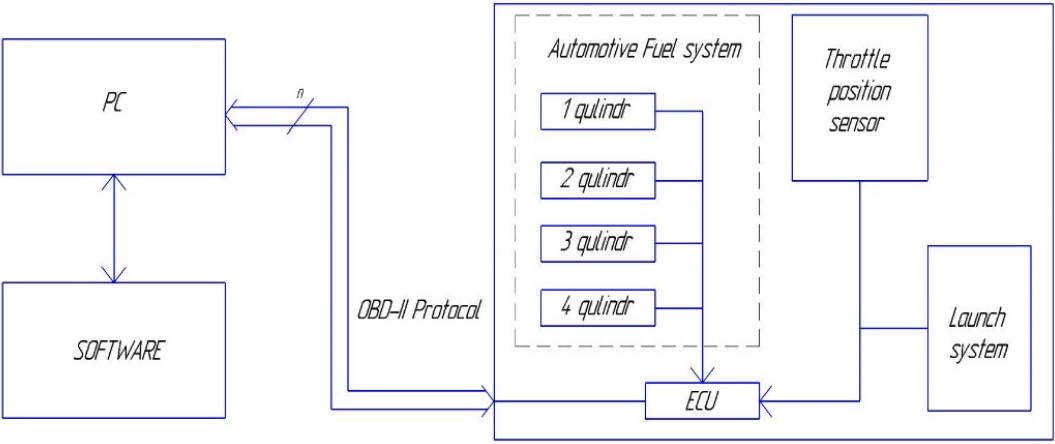
Figure 1. Block diagram explaining the measured procedure of experimental data.